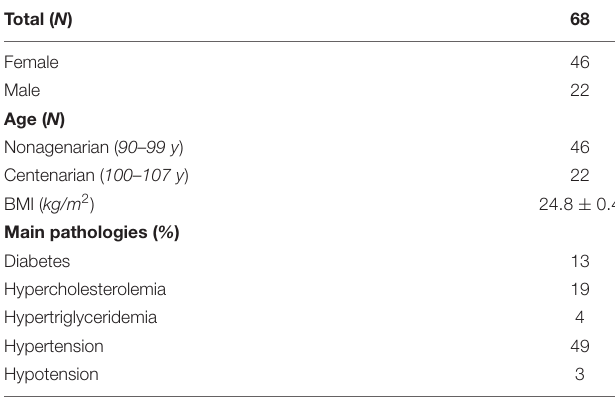
TABLE 1 | Demographic, anthropometric, and health status of the study